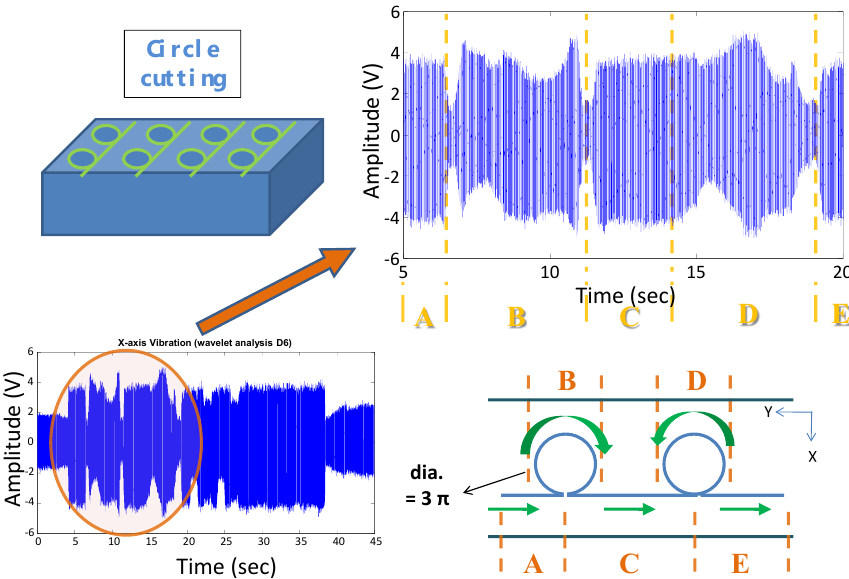
Figure 8. Signal change in circle path cutting (sharp tool in x − direction).